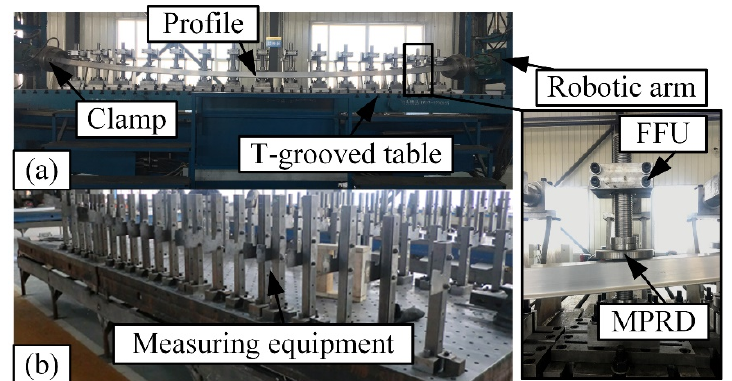
Figure 12. Experimental equipment. ( a ) FSB-MPRD experimental equipment. ( b ) Measuring equipment. Table 3. Experimental process parameters.